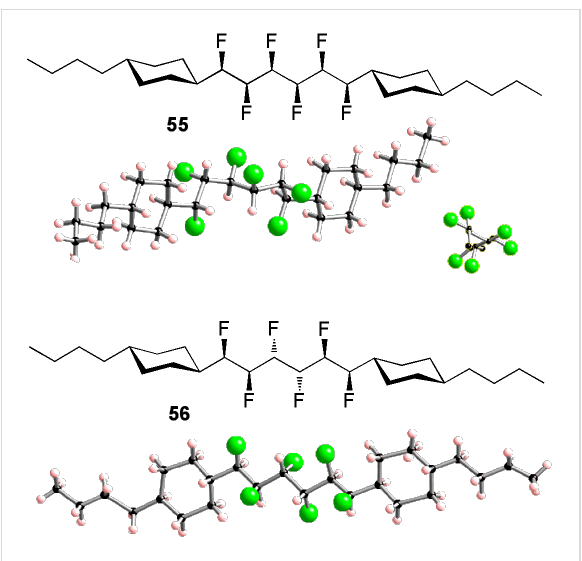
Figure 13: X-ray crystal structures of diastereoisomeric multi-vicinal fluoroalkanes 55 and 56 . The different conformations can be explained by (i) the avoidance of 1,3-difluoro repulsion and (ii) a preference for 1,2-difluoro gauche alignments.